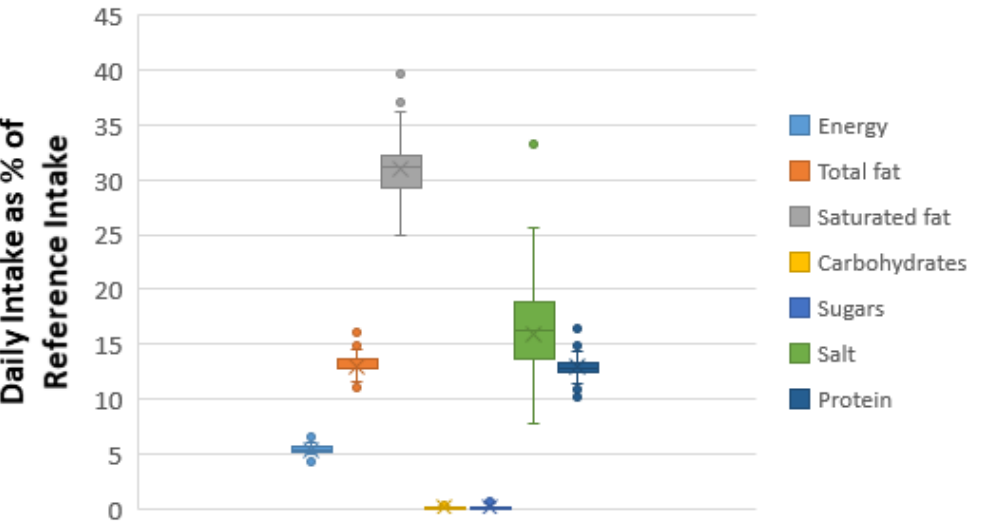
Figure 6. Daily intake per capita as a percentage of European daily reference intakes (RIs), for the 95th percentile of the daily consumption of prepacked feta cheese marketed in the Greek Market. 3.3. Evaluation of the Nutritional Profile of Feta Cheese Products against Five NPMs The 81 prepacked feta cheese products were evaluated against three threshold (I, II, and V) and two scoring (III and IV) nutrient profile models. The results of the evaluation are presented in Table 5.